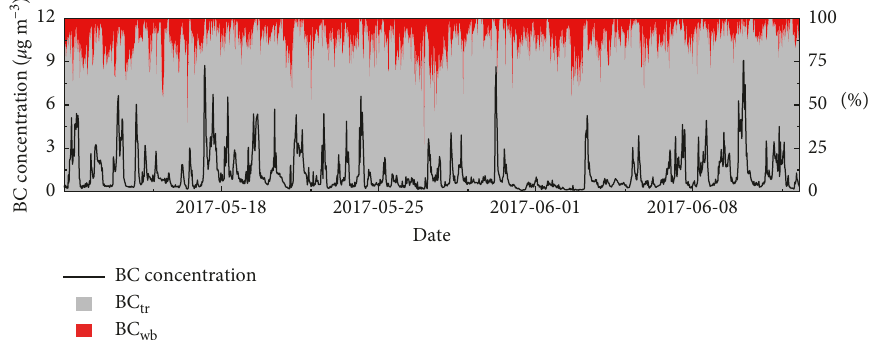
Figure 2: Time series of BC concentration (black) and contributions of BC